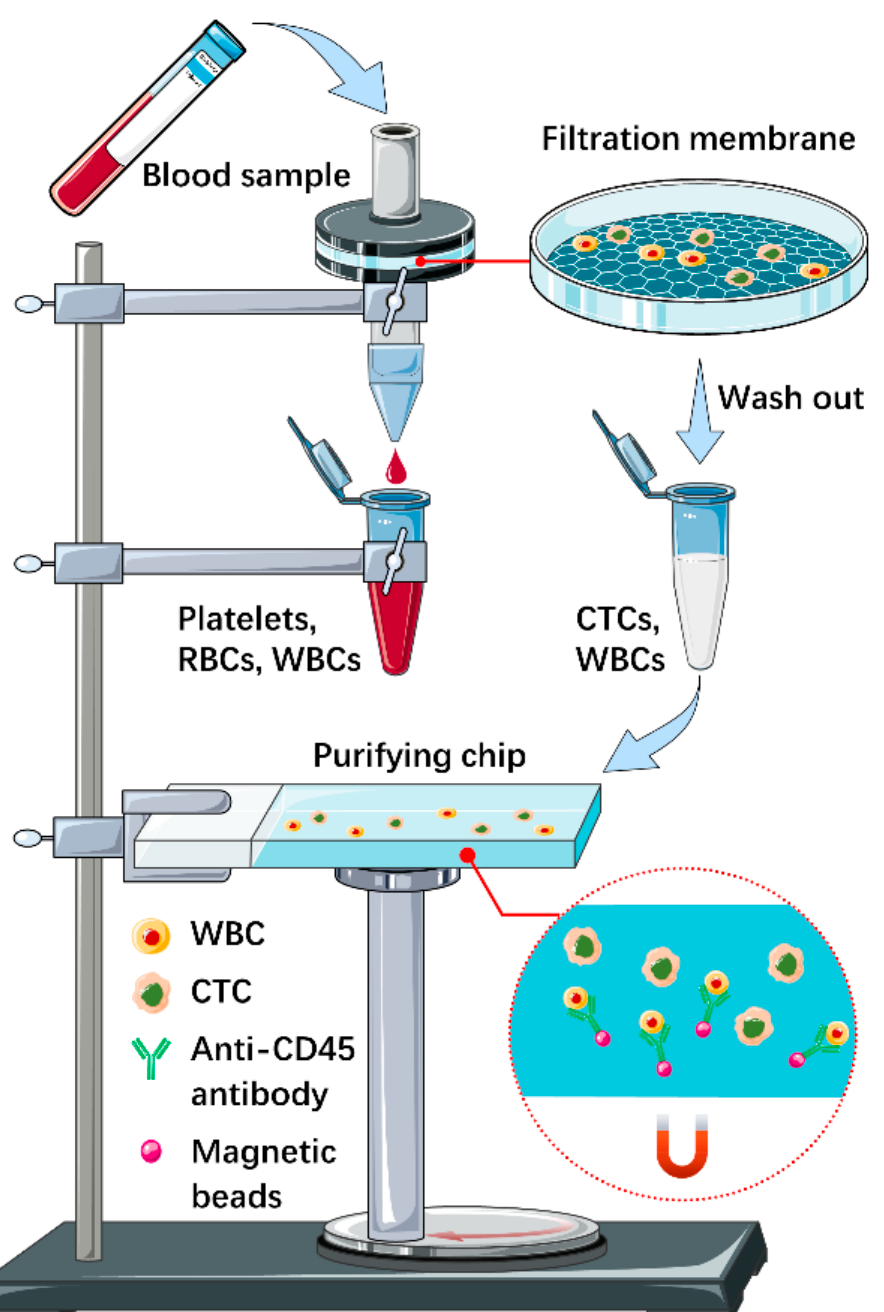
Figure 1. Schematic illustration of the integrated microfluidic circulating tumor cells (CTC) isolation platform. Taking lung cancer as an example, 2 mL blood sample was loaded into the device. All red blood cells (RBCs), platelets and most WBCs were filtered, while CTCs and some WBCs of large size were captured. Then CTCs and residual WBCs were washed off the membrane and transferred into the purifying chip, where WBCs would be further removed by CD45 dynabeads. Finally, the supernatant with CTCs and free WBCs was collected for identification and single-cell isolation. This work is licensed under a Creative Commons Attribution 3.0 Unported License. It is attributed to Mingxin